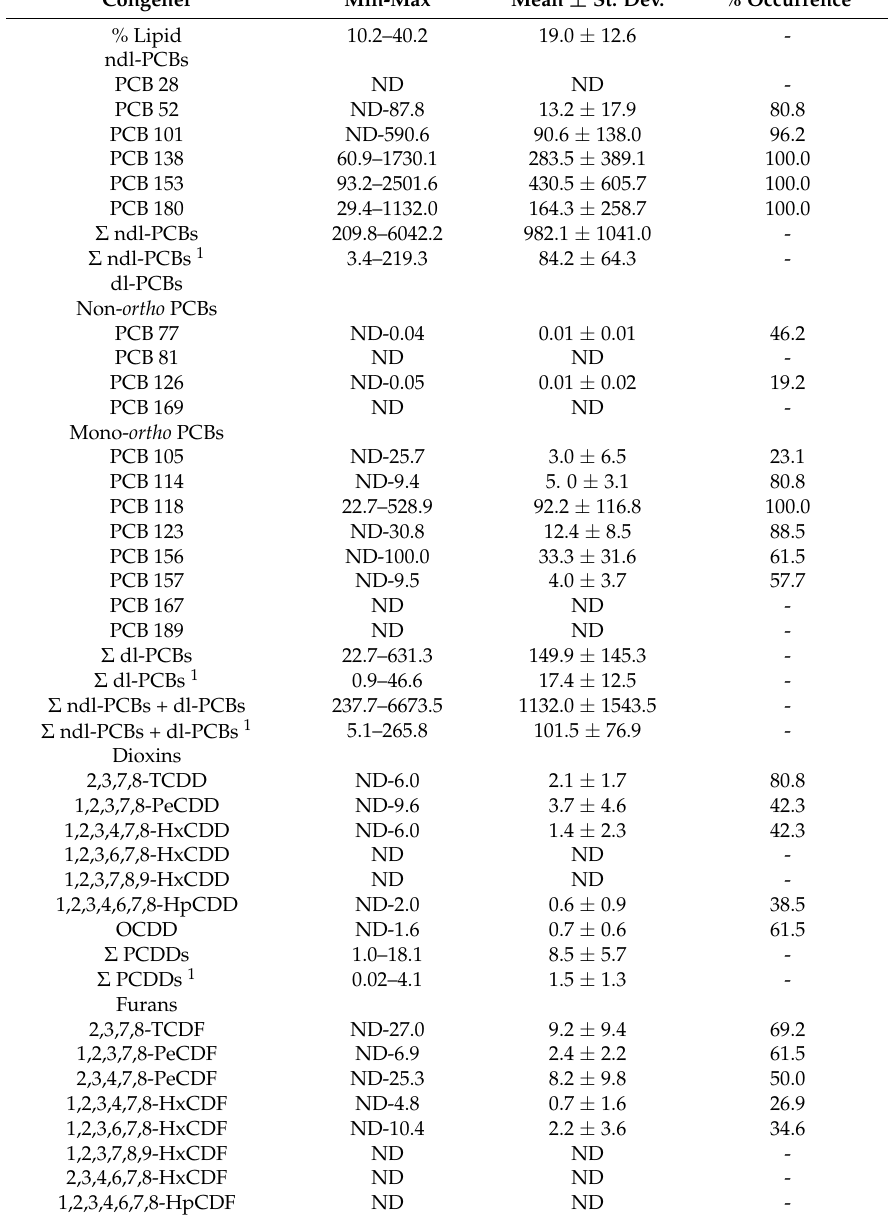
The polychlorinated biphenyls (PCBs) (ng g − 1 lipid weight) and The PCDD/Fs (pg g − 1 lipid weight) concentrations and occurrence in Bluefin tuna from The Mediterranean